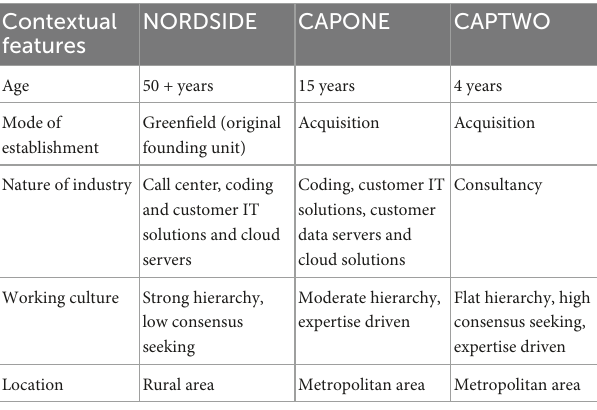
around 1,500 people primarily located in three units